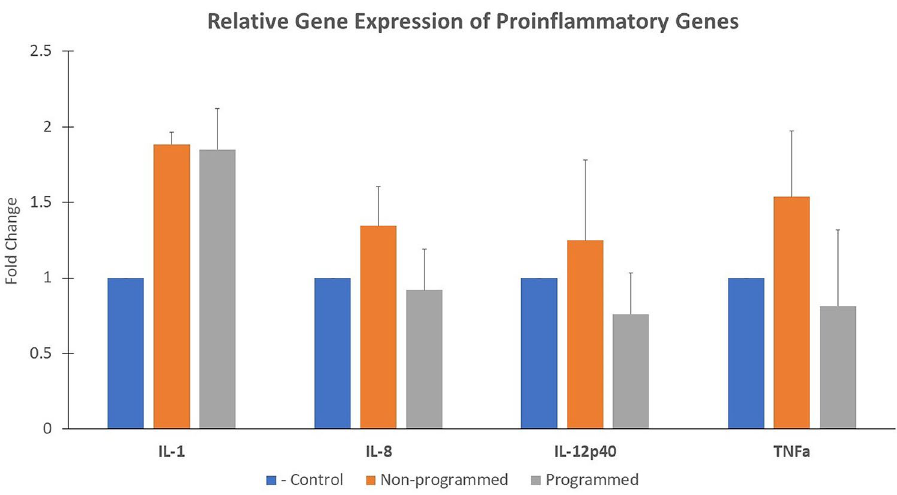
Figure 3. Relative gene expression. Relative gene expression of the group is represented as a fold change relative to the negative control group (fold change = 1). Values provided are mean fold change + S.E.M (standard error of the mean). Results of One-way ANOVA and Tukey test are shown on graphs when significant. No significant differences were detected.